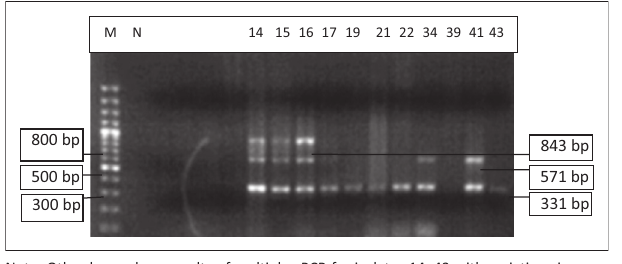
FIGURE 3: Multiplex 3. Lane M indicates the lane containing the marker, GeneRuler 100 bp Plus DNA Ladder (Thermo Scientific, Waltham, Massachusetts, USA). Isolates 24–44 all had the iutA (302 bp) gene.